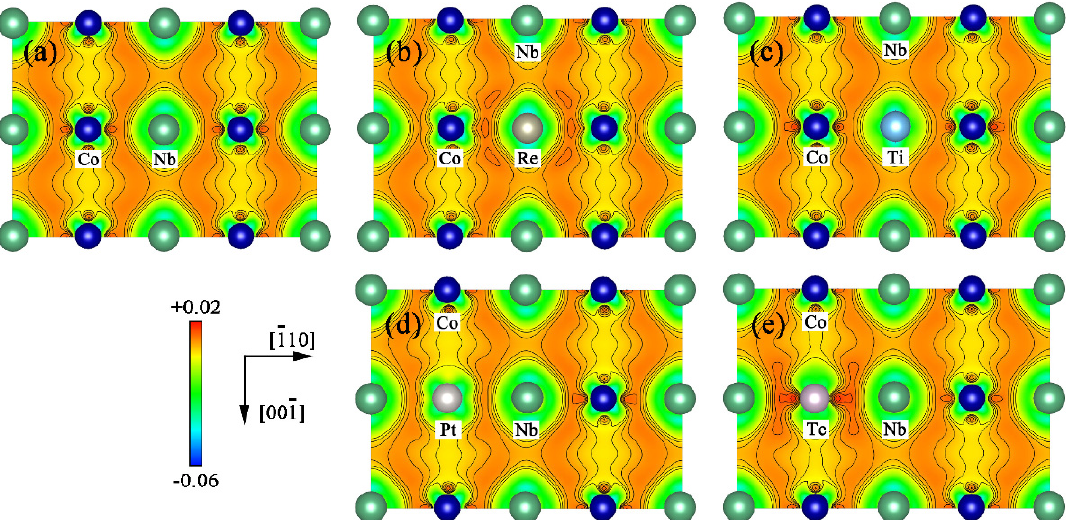
Figure 8. Calculated CDD in the (110) plane for ( a ) pure, ( b ) Re-substituted, ( c ) Ti-substituted, ( d ) Pt-substituted and ( e ) Tc-substituted L1 2 Co 3 Nb, respectively.